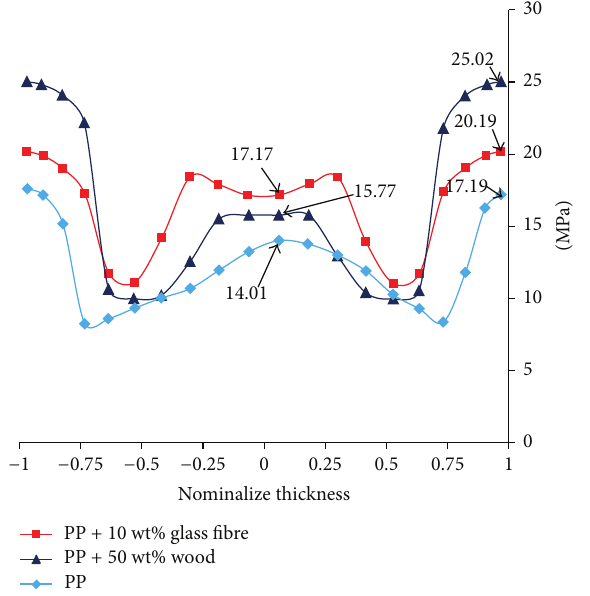
Figure 5: The residual tensile stress distribution occurs at the centre of the surface of the thin-walled parts for PP, PP + 10wt% glass fibre, and PP + 50wt% wood.